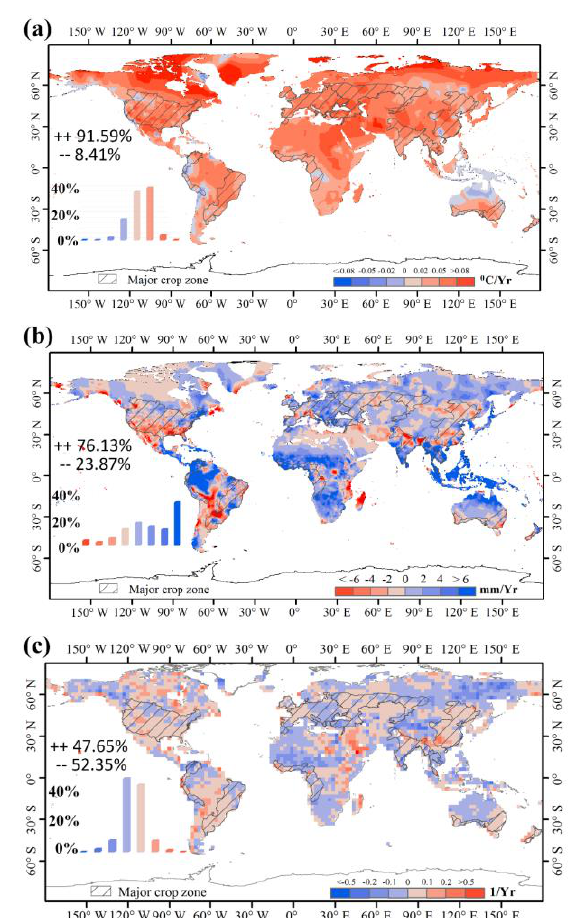
Figure S5. Spatial distribution of climate change over the past three decades. (a) Annual average precipitation change trend, (b) Annual average temperature change trend, and (c) Annual average PDSI change trend. The insets show the percentage distribution of corresponding change trends, and the marks “++” and “--” represent the total percentage of increase and decrease trend, respectively.